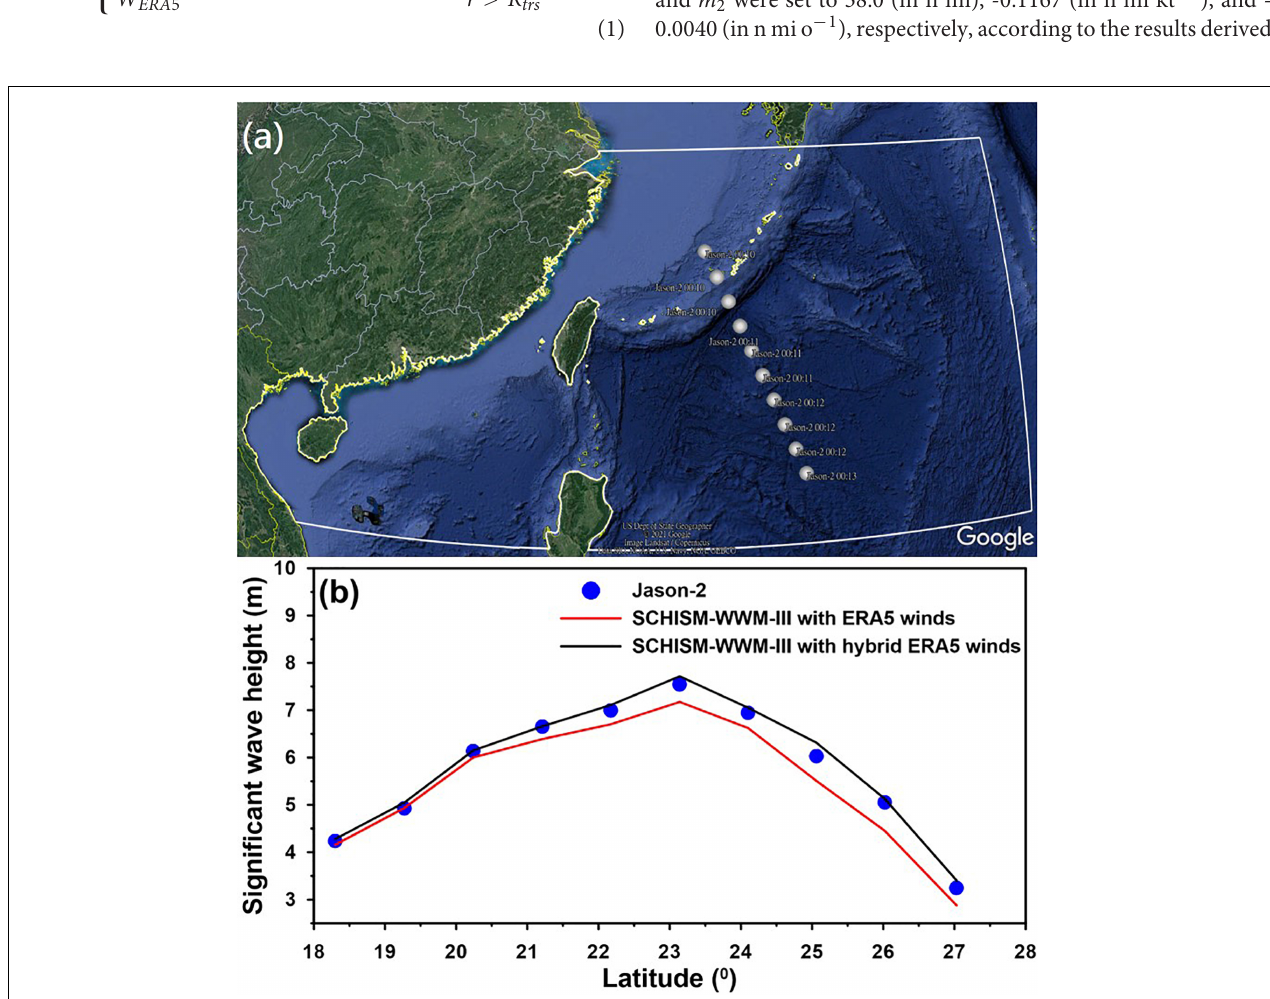
FIGURE 5 | (a) Jason-2 orbit in the computational domain at UTC 00:00 on August 8, 2019, and (b) along-track significant wave heights measured by altimeter on Jason-2 with hindcasted significant wave heights derived from the original ERA5 and modified ERA5 wind fields for Super Typhoon Lekima in 2019.